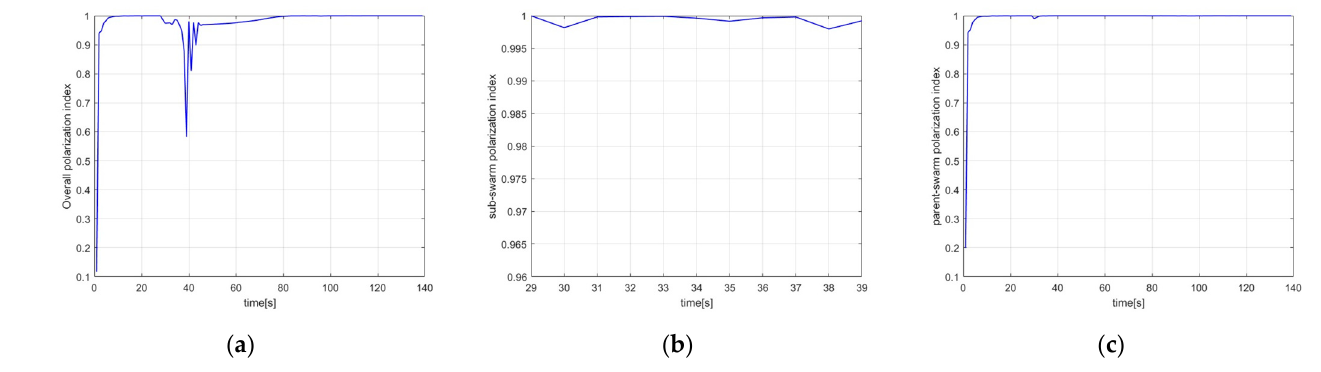
Figure 4. Polarization index in the fission–fusion process of the UAV swarm without an anti-capture situation. ( a ) overall polarization index; ( b ) sub-swarm polarization index; ( c ) parent swarm polarization index.